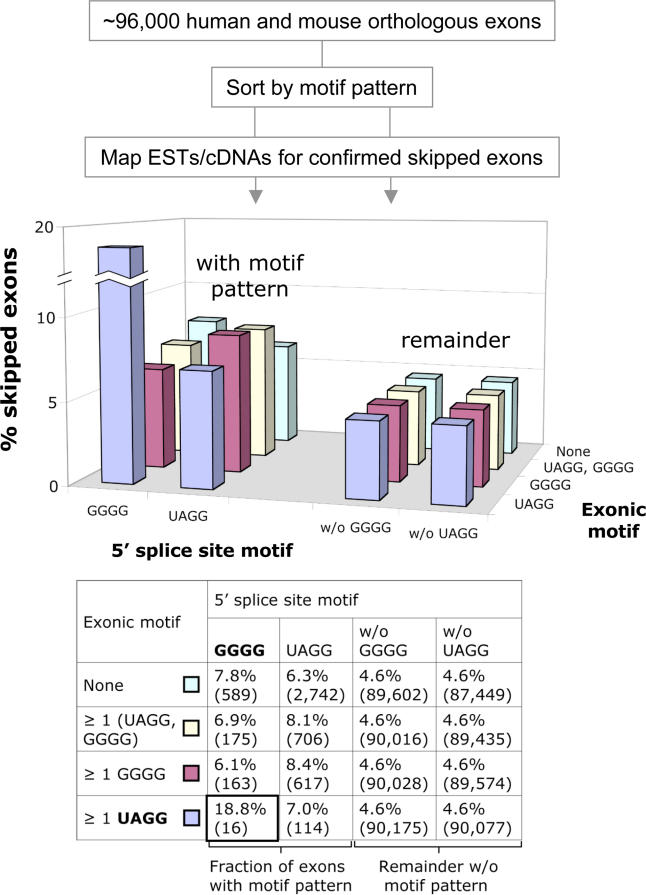
Computational Analysis of UAGG and
GGGG Motif Patterns Reveals Association with Exon Skipping Genome-Wide
At the top is a flow chart for the computational analysis used to illustrate the procedure used to identify human exons with and without the CI cassette silencer motif pattern (≥1 exonic UAGG and a 5′-splice-site-proximal
GGGG), followed by the determination of the percentage of confirmed skipped exons in each group. The reciprocal pattern (≥1 exonic
GGGG and a 5′ splice site UAGG) and related variants were analyzed for comparison as indicated in the graph and table. The graph (middle) shows exons with the motif pattern on the left and the remaining exons without the pattern (w/o) on the right; x-axis, 5′ splice site motif; y-axis, percent confirmed skipped exons; z-axis, exonic motif. Confirmed skipped exons were defined as those skipping events supported by 20 or more individual cDNA and/or EST entries. Exonic motifs were allowed at any position within the exon, but not overlapping the splice sites, and the 5′ splice site motif was restricted to bases 3–10 of the intron. Only exons of 250 nucleotides or fewer were considered. The table (bottom) shows, for each motif pattern, the percentage of confirmed skipped exons within that group (as shown in the graph) and the number of exons in the group (in parentheses). The CI cassette silencer motif pattern is boxed.